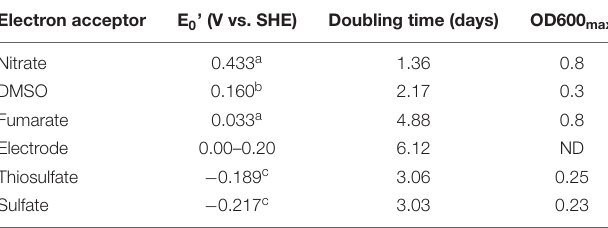
Redox potentials of electron acceptors obtained from literature are included. The electrode potential was derived from supplementary electrochemical data as explained in the text. a Thauer et al.,